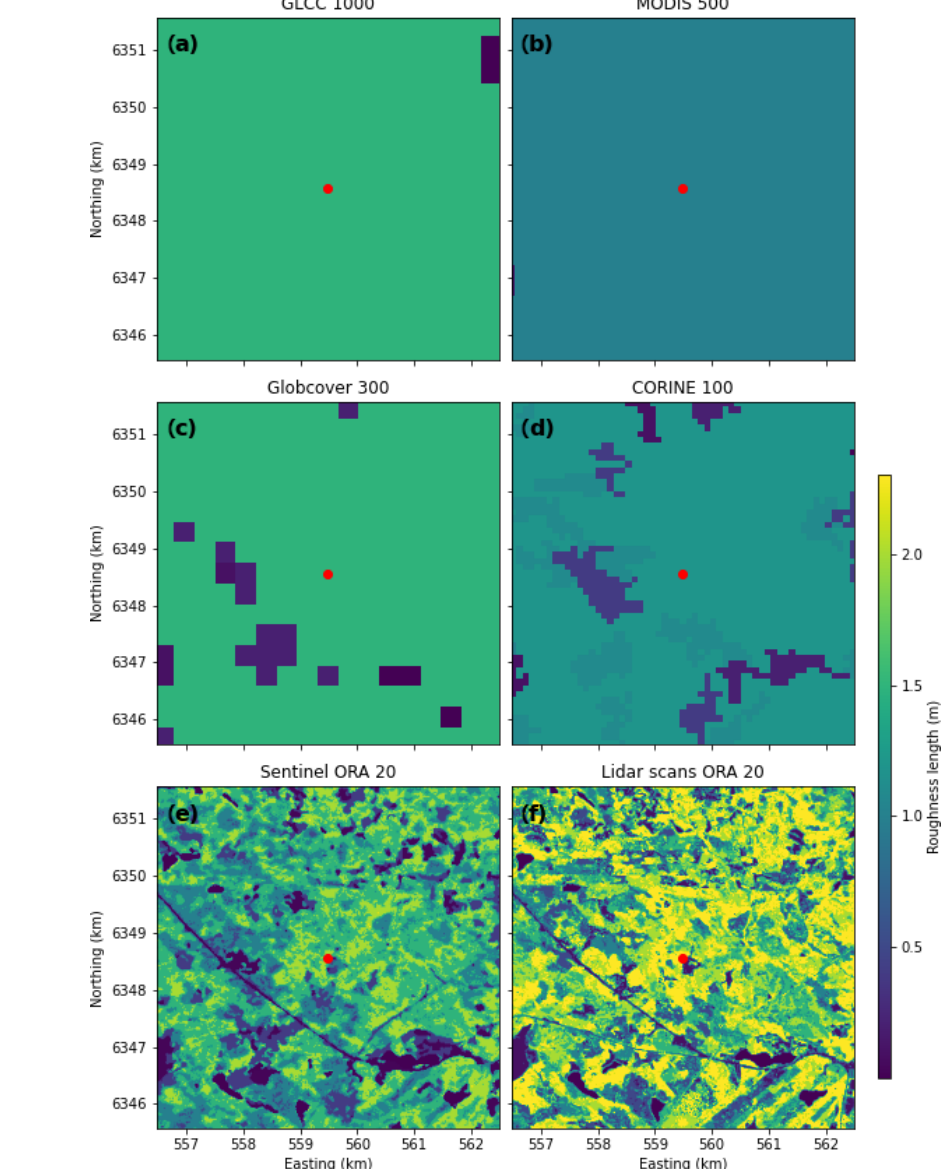
Figure 4. Roughness lengths obtained from a 6 × 6km square around the Ryningsnäs site (red point) from standard land cover data sets (a–d) , novel Sentinel data sets (e) , and aerial lidar scans (f) . The time periods for which the different data sets are obtained are shown in Table